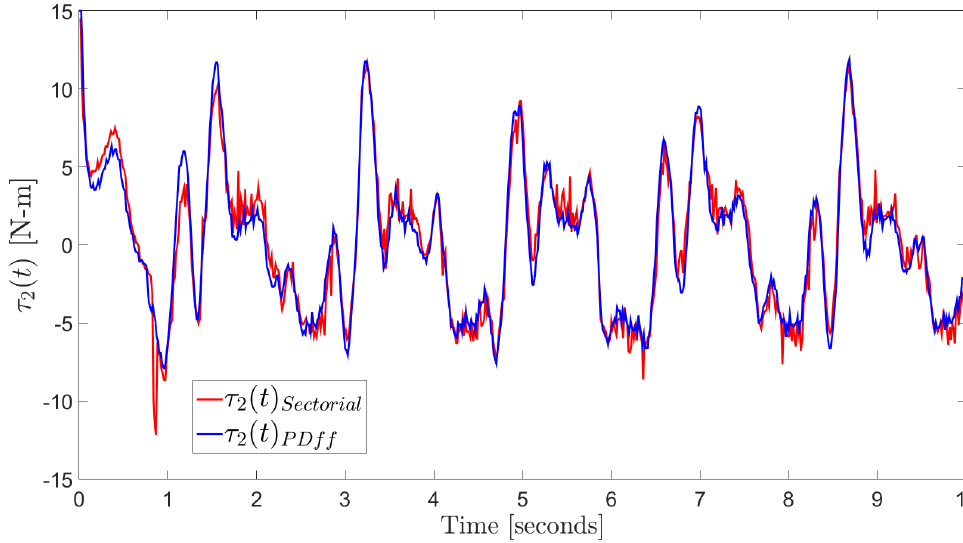
Figure 28. Applied torque to joint 2.